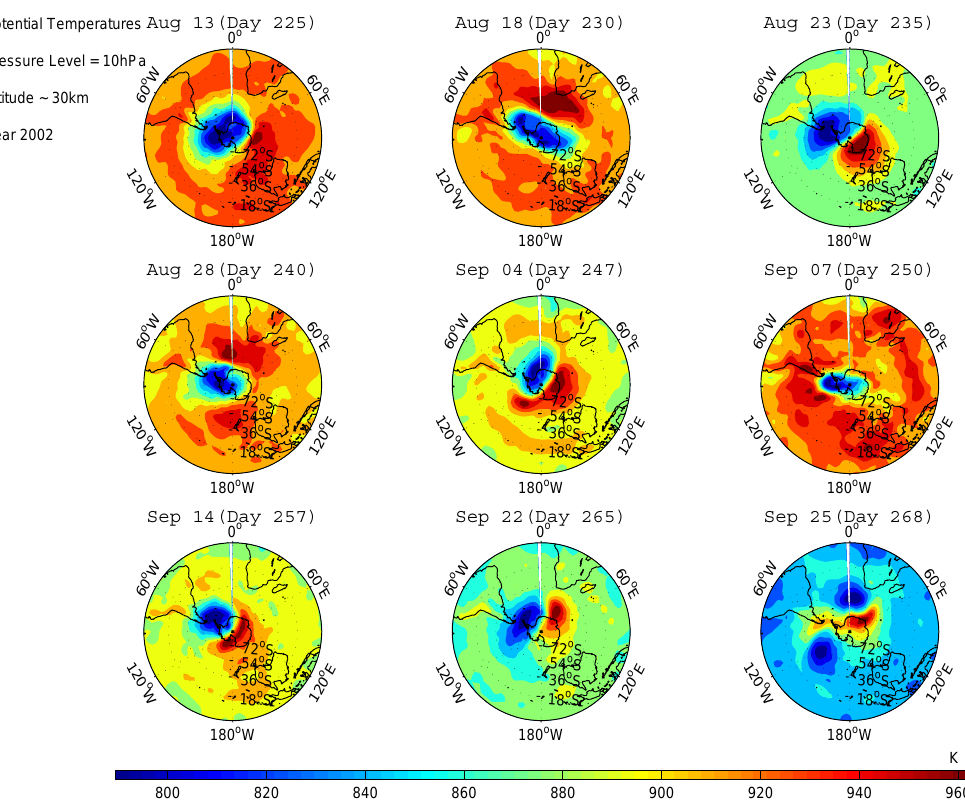
Fig. 4. Southern Hemisphere potential temperature maps at 10hPa pressure level for selected days in August and September of 2002. Fields are derived from NCEP temperatures.